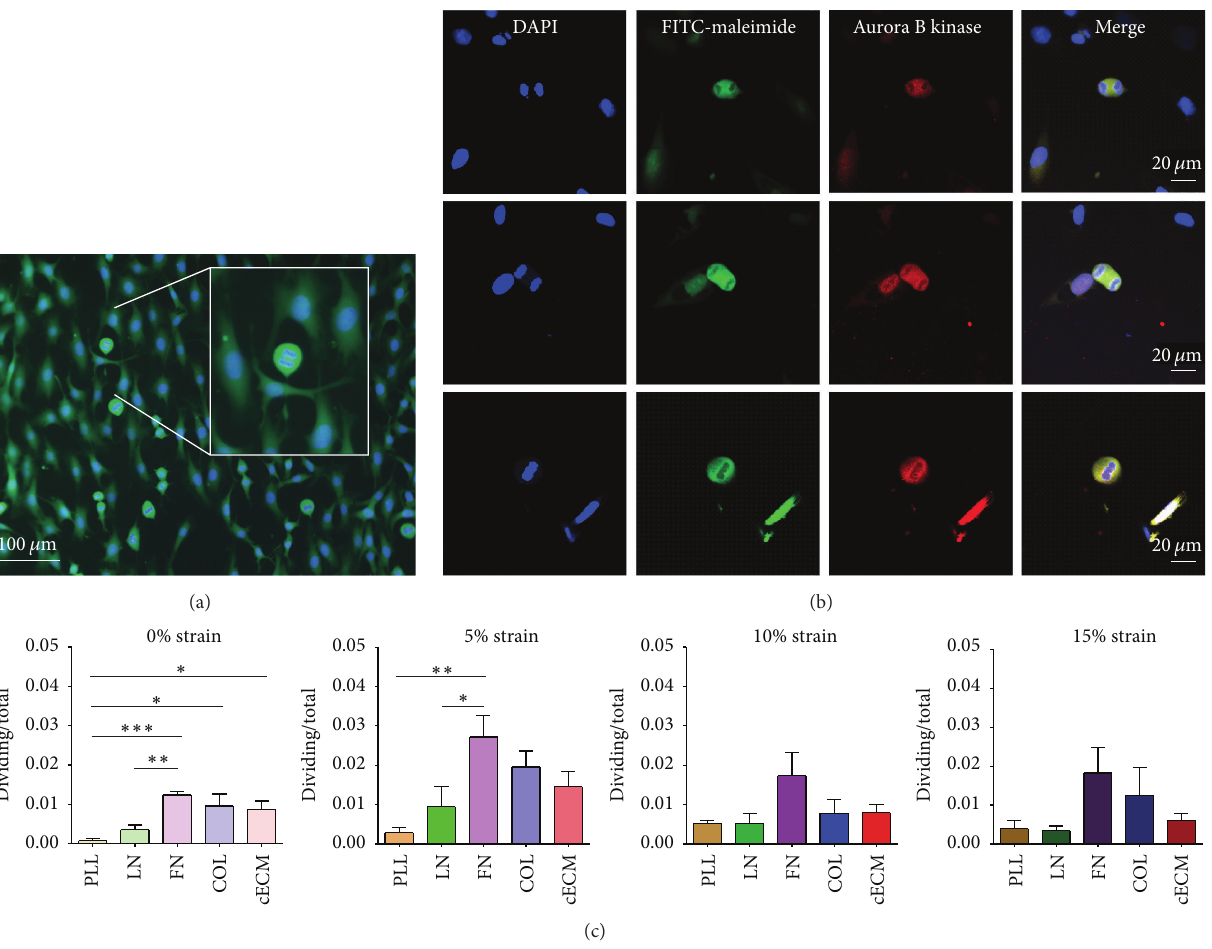
Figure 3: Fibronectin increases CPC division at low strain magnitudes. CPCs were seeded on each matrix for 6 hours and then cyclic strain was applied for 24 hours. (a) Representative image showing nuclear condensation and cytokinesis. Blue: DAPI and green: FITC-maleimide. Insert shows magnification of a dividing cell. (b) Representative image of aurora B kinase staining. Blue: DAPI, green: FITC-maleimide, and red: aurora B kinase. (c) Quantified results; one-way ANOVA with Tukey’s multiple comparison test; bars represent mean + SEM; ∗ 𝑝 < 0.05 , ∗∗ 𝑝 < 0.01 , and ∗∗∗ 𝑝 < 0.001 ; 𝑛 = 4 –6; PLL (brown): poly-L-lysine, LN (green): laminin, FN (purple): fibronectin, COL (blue): collagen I, and cECM (red): naturally derived cardiac extracellular